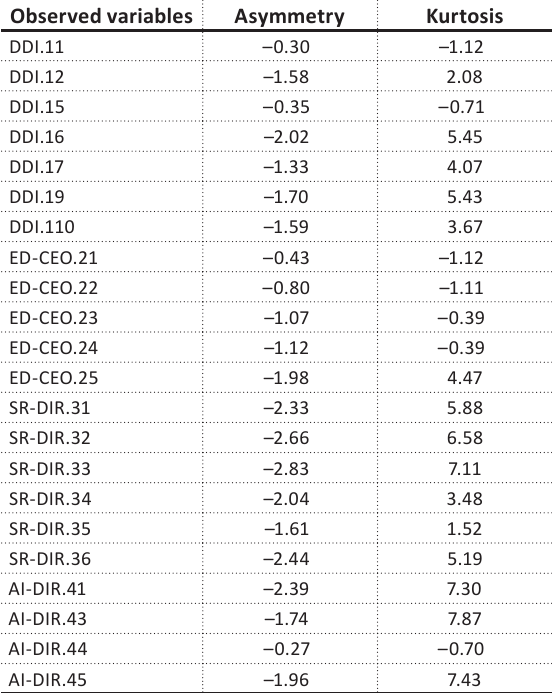
Table 4. Univariate normality test –